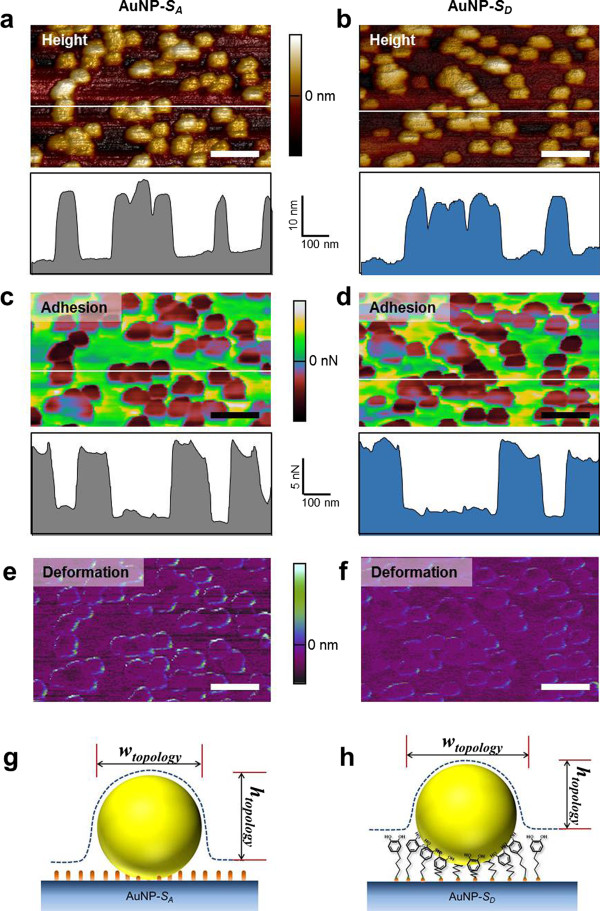
PeakForce QNM analysis of AuNP-immobilized surfaces. (a, b) Topographic AFM images of 20 nm of AuNPs immobilized on aminated surface and DOPA-functionalized surface, respectively. (c, d) Adhesion images of the samples show relative adhesion interaction between the bare Si AFM tip and AuNPs or other regions outside the AuNPs. All scale bars are 200 nm. The dashed line is a depiction of AFM stylus trajectory. (e, f) AFM deformation images show a larger deformation change near the edge than at the center of the nanoparticles. (g, h) Schematic diagram of the geometric design depicted AuNPs immobilized on the substrates functionalized with amino group and DOPA molecules, respectively. The terms wtopology and htopology indicate the measured width and height, respectively, of the AuNPs in the aspect of topology (a, b).